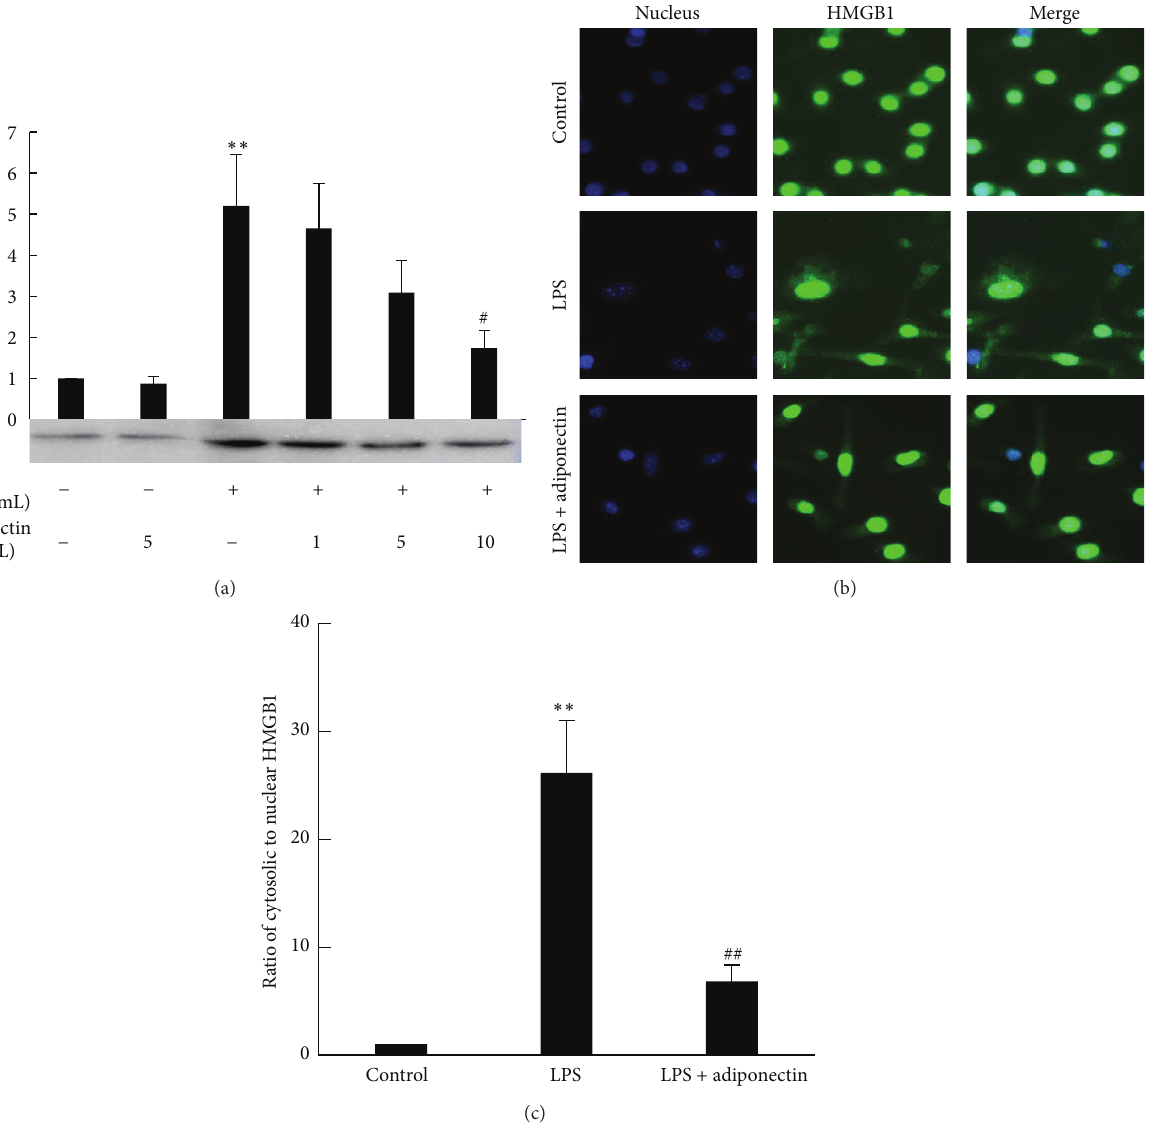
Figure 1: Effect of recombinant adiponectin on LPS-induced HMGB1 release and HMGB1 cellular translocation. Raw 264 cells were cultured in DMEM supplemented with 10% FBS and were cultured in serum-free OPTI-MEM I medium for additional 12h. The cells were treated with increasing concentrations of adiponectin for 18 h, then stimulated with LPS (200ng/mL) for another 24 h. (a) Culture medium was collected and analyzed by HMGB1 western blotting, followed by quantification of the intensity of the chemiluminescent HMGB1 band. The results are expressed as means ± SE of three independent experiments ( ∗∗ 𝑝 < 0.01 significance compared with control; # 𝑝 < 0.05 significance compared with LPS treated cells). (b and c) Cellular HMGB1 was immunostained with an anti-HMGB1 rabbit primary and Alexa Fluor 488 anti-rabbit secondary antibodies. The nucleus was stained with DAPI. Merge indicates the combination of both HMGB1 (Green) and nuclear (Blue) fluorescence. The fluorescence intensities of cytosolic and nuclear HMGB1 in (b) were separately analyzed and the ratio of cytosolic HMGB1 to nuclear HMGB1 is shown in (c) ( ∗∗ 𝑝 < 0.01 significance compared with control; ## 𝑝 < 0.01 significance compared with LPS treated